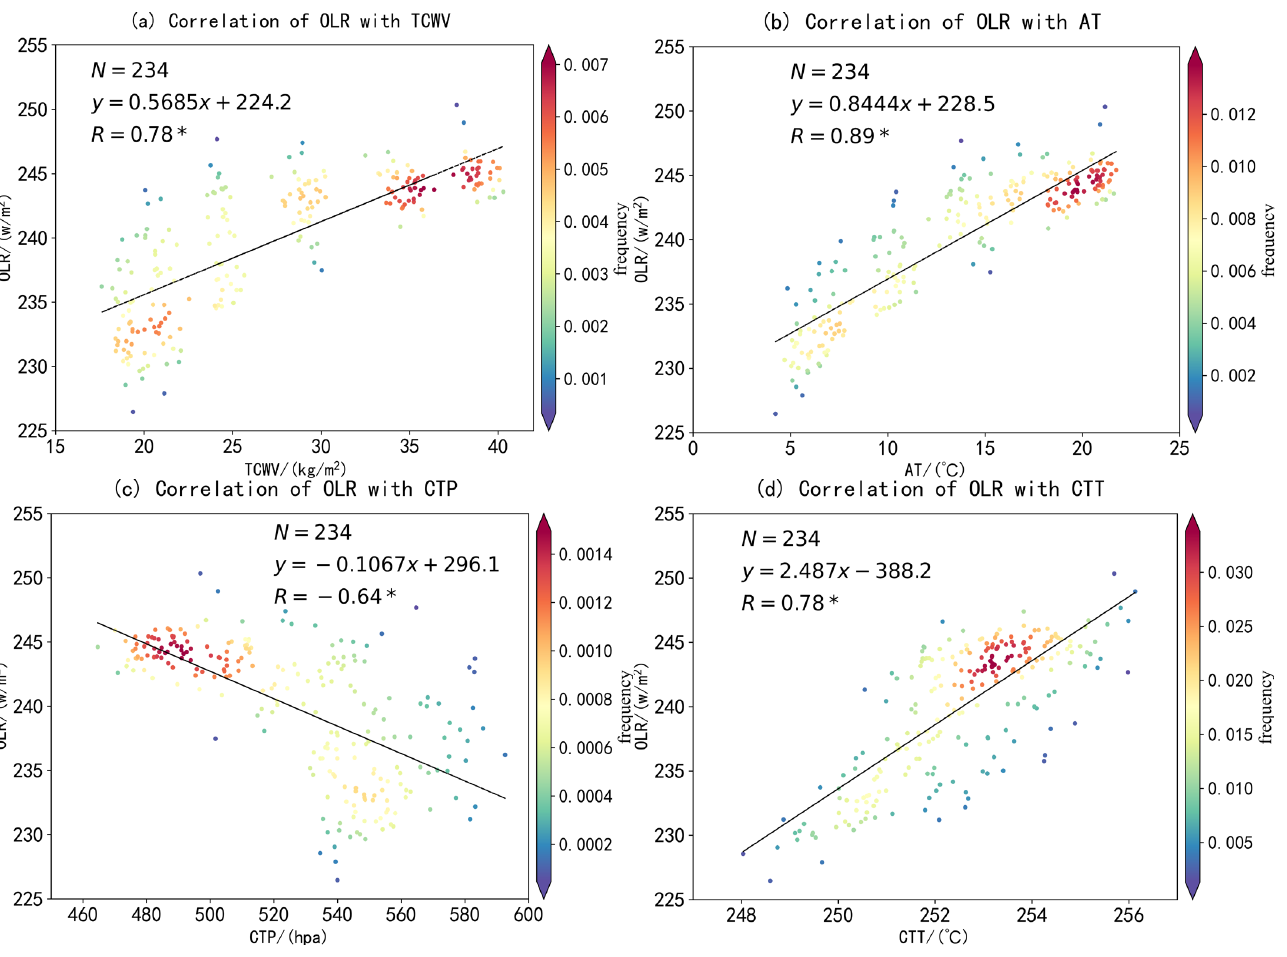
Figure 9. The correlation between OLR and various factors. * Indicates passing the 99% significance test. ( a ) OLR and TCWV. ( b ) OLR and AT. ( c ) OLR and CTP. ( d ) OLR and CTT.